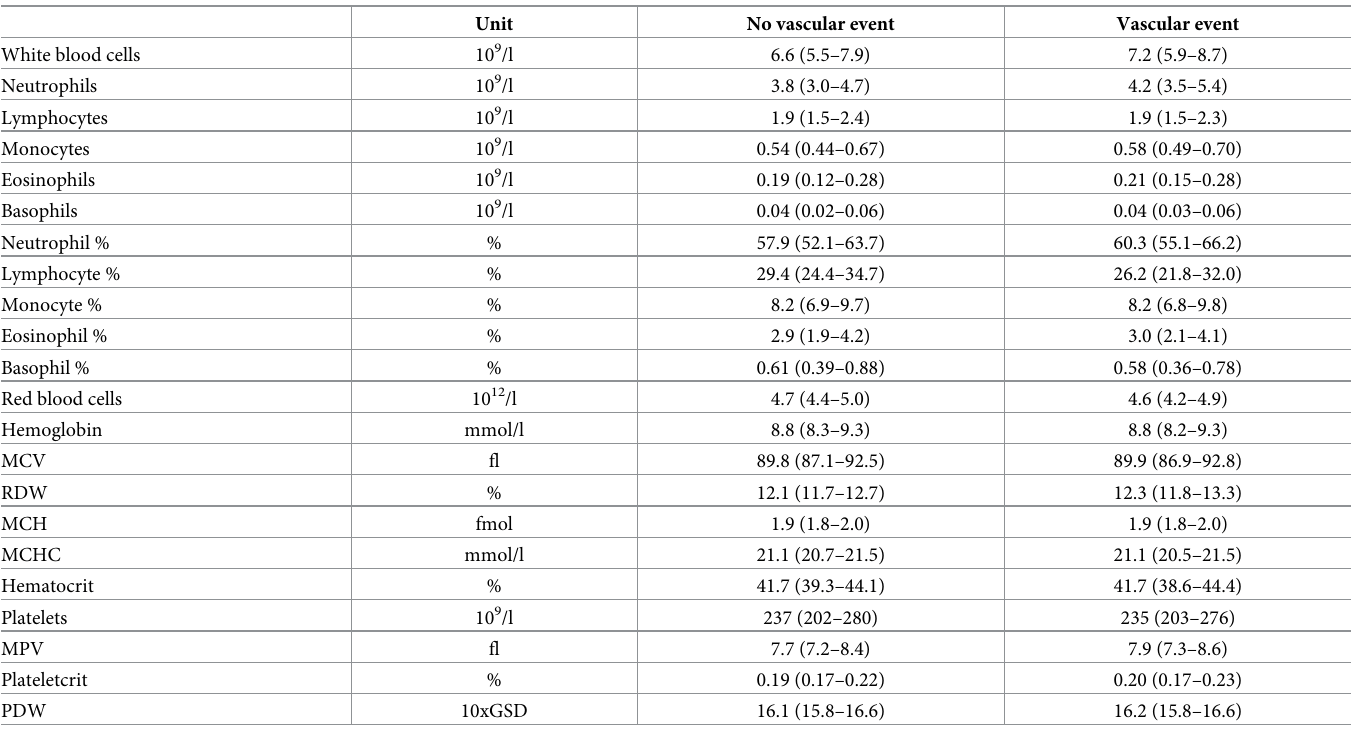
Table 2. Hematological parameters.